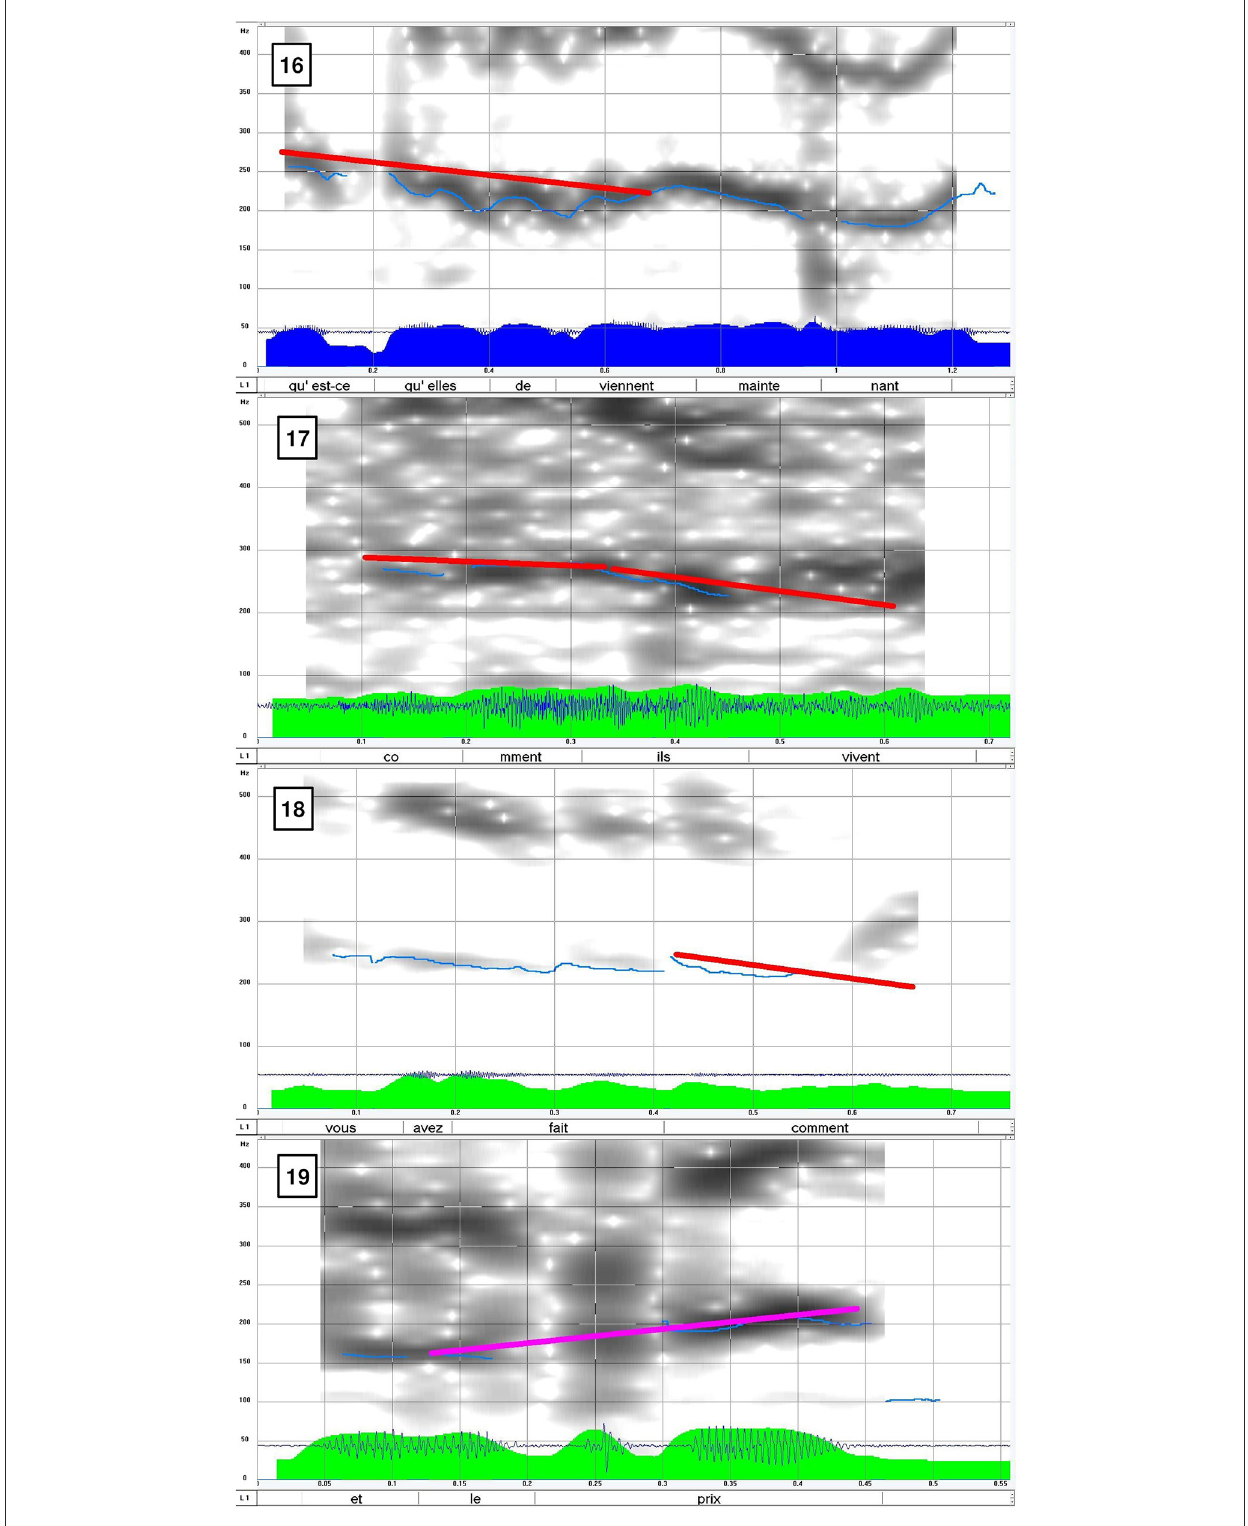
FIGURE10 Prototypic contours of Partial questions and Open questions in French (16–19) (Supplementary Audio